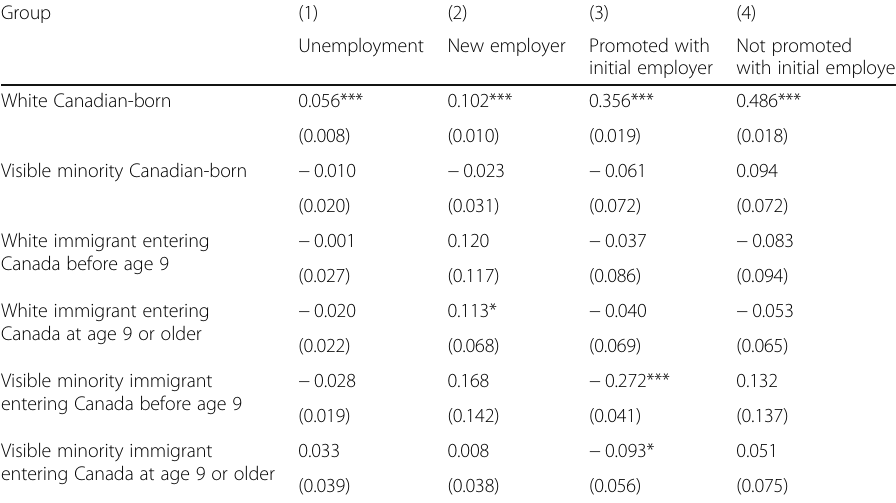
Table 3 Transition probabilities by age-at-immigration